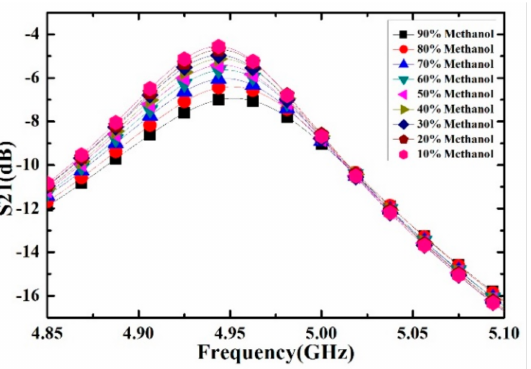
Figure 11. Measured transmission response of different concentrations of methanol solution.